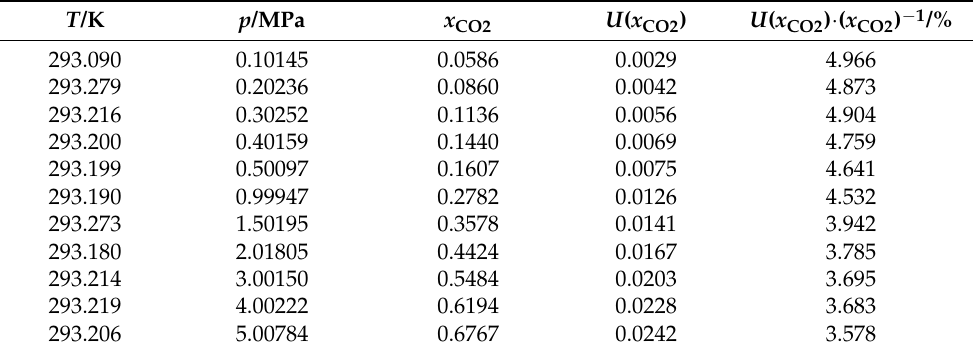
Table A6. Experimental results for solubility measurements of pure carbon dioxide in [Bmim][Tf 2 N] at T = 293.15 K using Raman spectroscopy. Recorded temperature (ITS-90), pressure, mol fraction, and estimated uncertainties ( k = 2) are listed in the table.